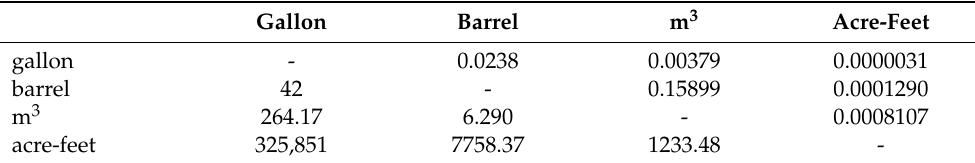
Table 3. Volume unit